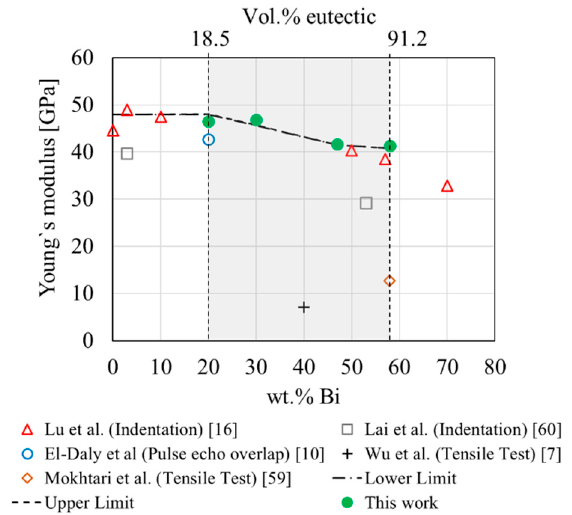
Figure 10. RVE-FE results, linear/inverse mixing rule and literature values of Young’s modulus.